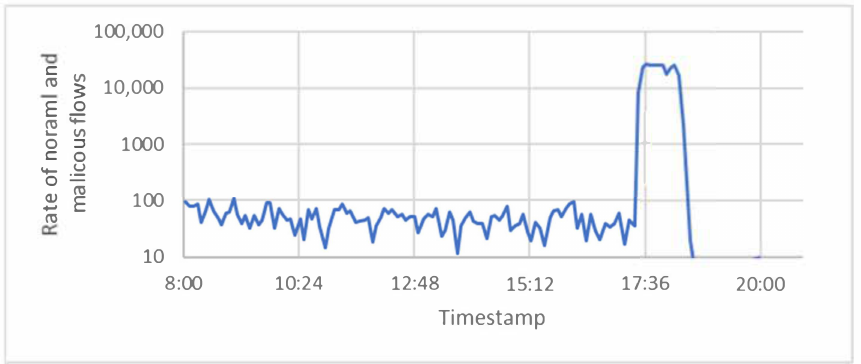
Figure 4. Number of benign and malicious flows per timestamp for the Friday_1998